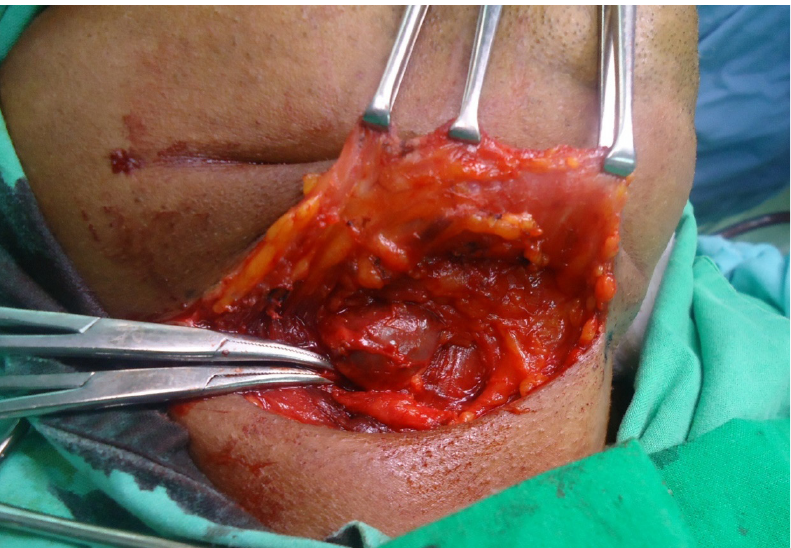
Figure 1: Symptomless swelling of gradual onset in submandibular region – Following sub-platysmal dissection to expose the lesion.